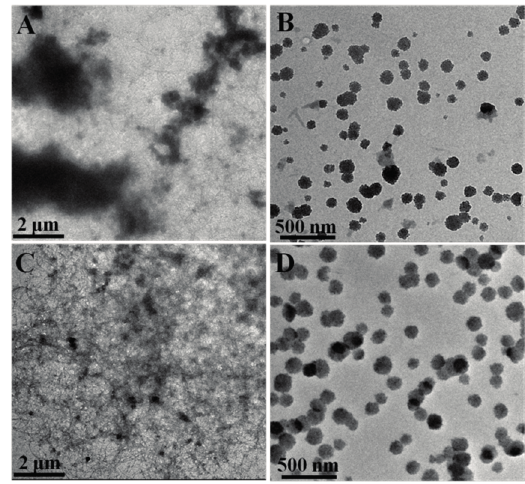
Figure 4. TEM images of Complex1 ( A ) before and ( B ) after high pressure homogenization as well as Complex2 ( C ) before and ( D ) after high pressure